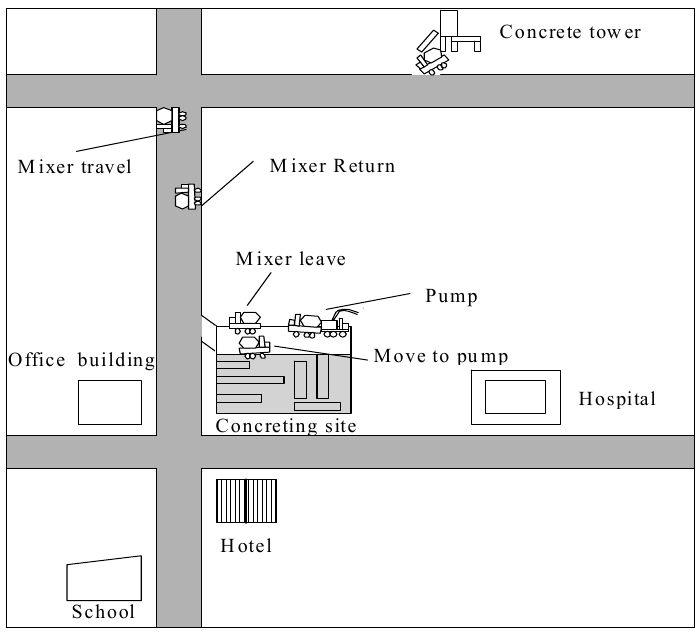
Figure 5. Layout of the foundation concreting project.